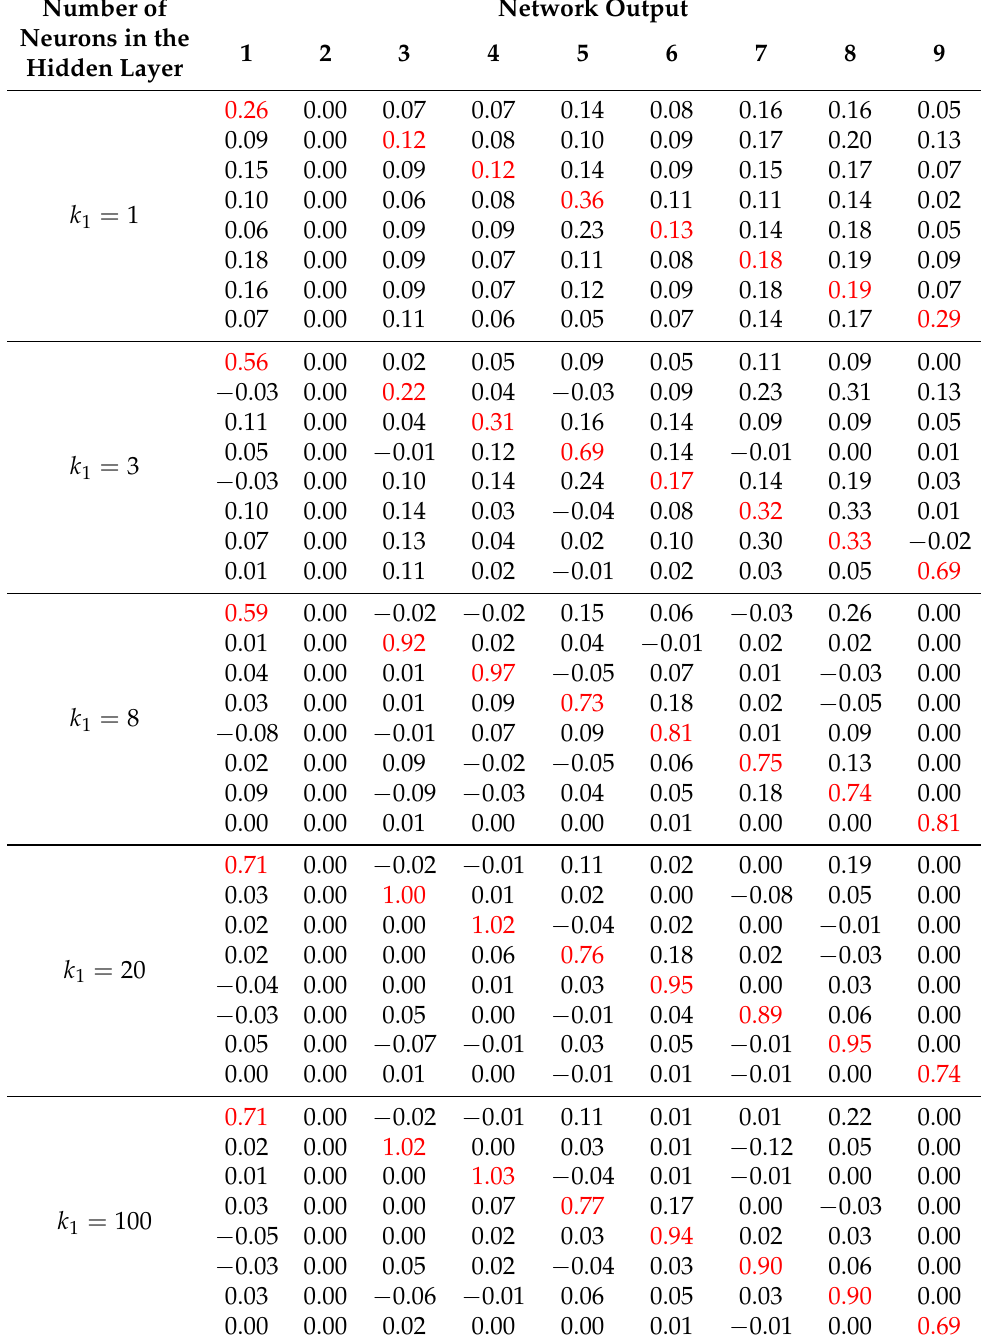
Table 1. Results obtained in network tests (impact of the number of neurons in the hidden